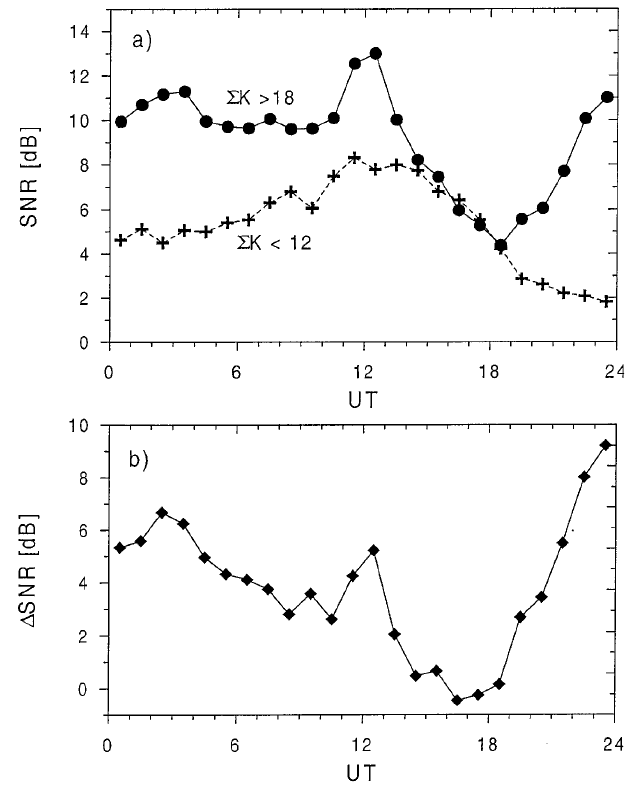
Fig. 4a, b. Mean diurnal variation of SNR (83.0–87.5 km, Andenes) for a two di(cid:128)erent levels of geomagnetic activity ( S K < 12 and